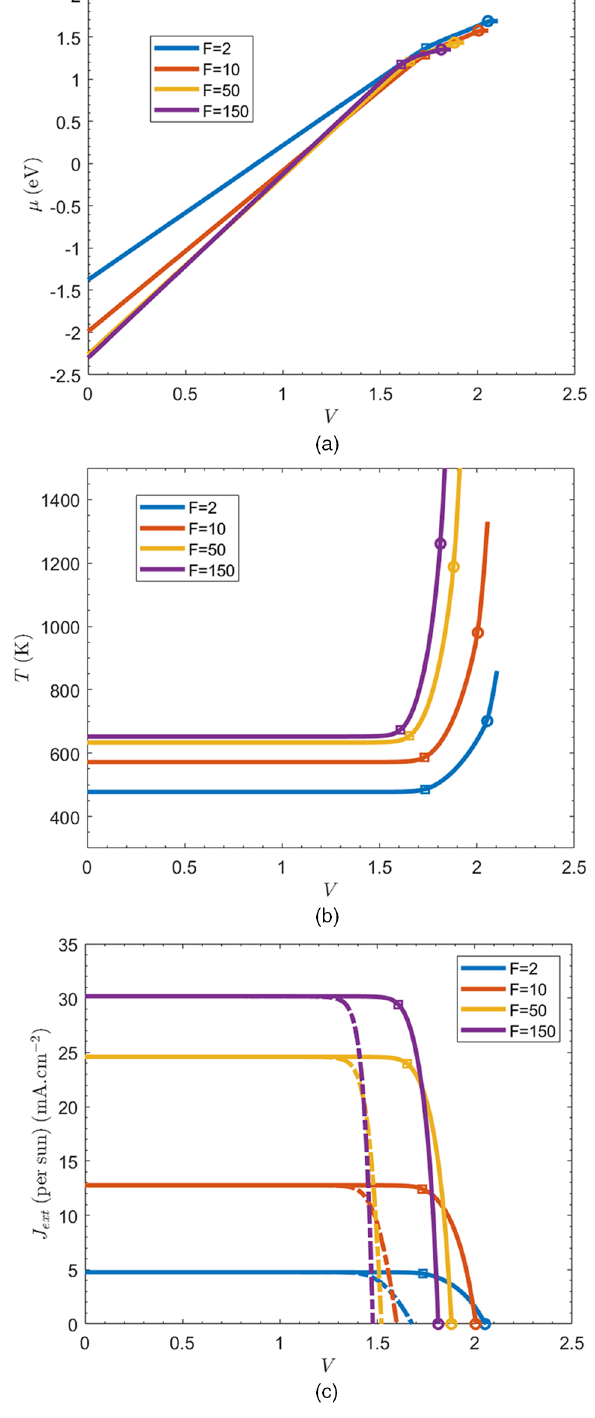
Fig. 4. (a)Chemicalpotential,(b)temperatureofthecarriers,and (c) extracted current (per sun) of a conventional cell and an HCSC, in dashed and continuous line, respectively, as a function of the applied voltage. The squares and circles respectively indicate the maximum power point and open circuit of the HCSC. These results are obtained for Q =1Wcm (cid:2) 2 K (cid:2) 1